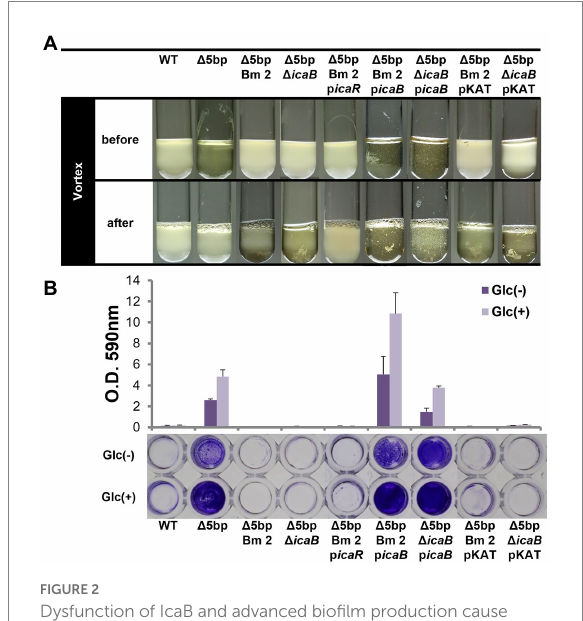
FIGURE 2 Dysfunction of IcaB and advanced biofilm production cause aggregation. Combination of IcaB dysfunction and 5-bp deletion cause autoaggregation. Autoaggregation assay (A) and biofilm assay (B) of various Staphylococcus aureus FK300 and the associated mutants: FK300 Δ 5bp; FK300 Δ 5bpBm 2; FK300 Δ 5bp Δ icaB ; and FK300 Δ 5bpBm 2 complemented with pKAT carrying icaR (p icaR ), icaB (p icaB ), or pKAT, whereas FK300 Δ 5bp Δ icaB complemented with p icaB or pKAT. Autoaggregation assay was carried out as shown in Figure 1.